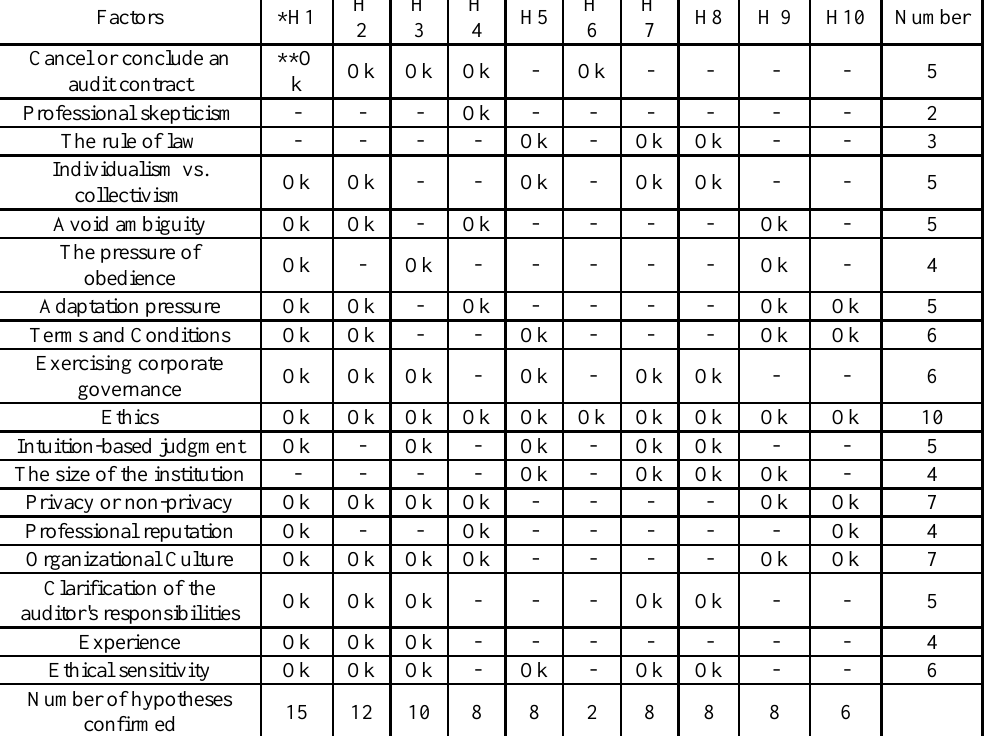
Table 8. Summary of component affecting conflict of interest of confirmed in the